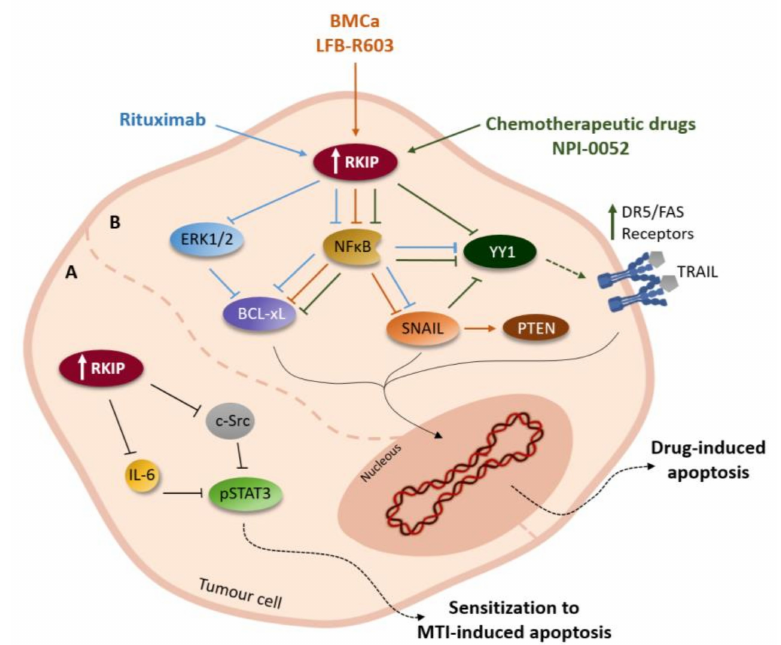
Figure 3. RKIP-mediated signalling accountable for drug-induced apoptosis sensitization in cancer cells. ( A ) Overexpression of RKIP leads to reduction of c-Src- and IL-6 -mediated signal transducer and activator of transcription 3 (STAT3) activation. Such will ultimately result in cell sensitization to Microtubule Inhibitors (MTI)-induced apoptosis. ( B ) Treatment of tumour cells with therapies such as chemotherapeutic drugs and monoclonal antibodies have as mechanism of action the upregulation of RKIP. This will result in the inhibition of pathways such as NF- κ B and MAPK, which in turn will block proteins like Bcl-xL and transcription factors like Yin Yang 1 (YY1) and Snail, culminating in upregulation of death receptor 5 (DR5) expression and derepression of phosphatase and tensin homolog (PTEN), respectively. These events sensitize cells to drug-induced apoptosis, including through TNF-related apoptosis-inducing ligand (TRAIL)-induced apoptosis. Each colour represents the di ff erent groups of